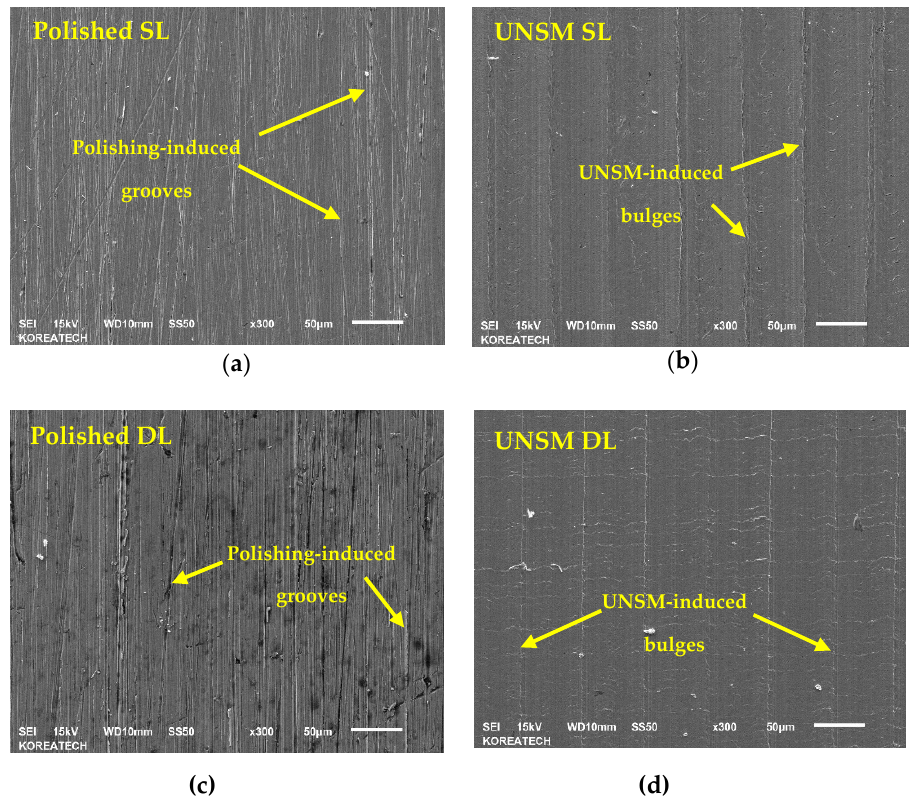
Figure 5. SEM images of the polished and UNSM-treated surfaces of the single ( a , b ) and double ( c , d ) layers.